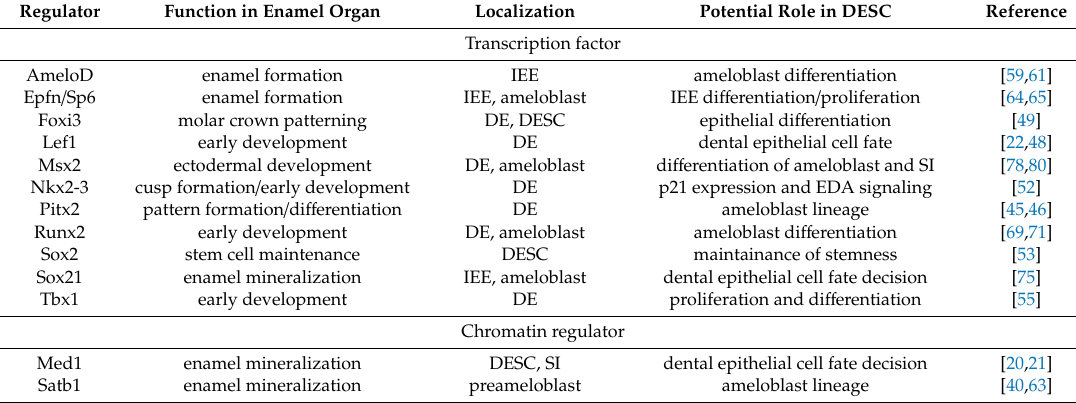
Table 1. The function of transcription factors and chromatin regulators in enamel organ and their potential role in dental stem cells. The localization of these factors is also